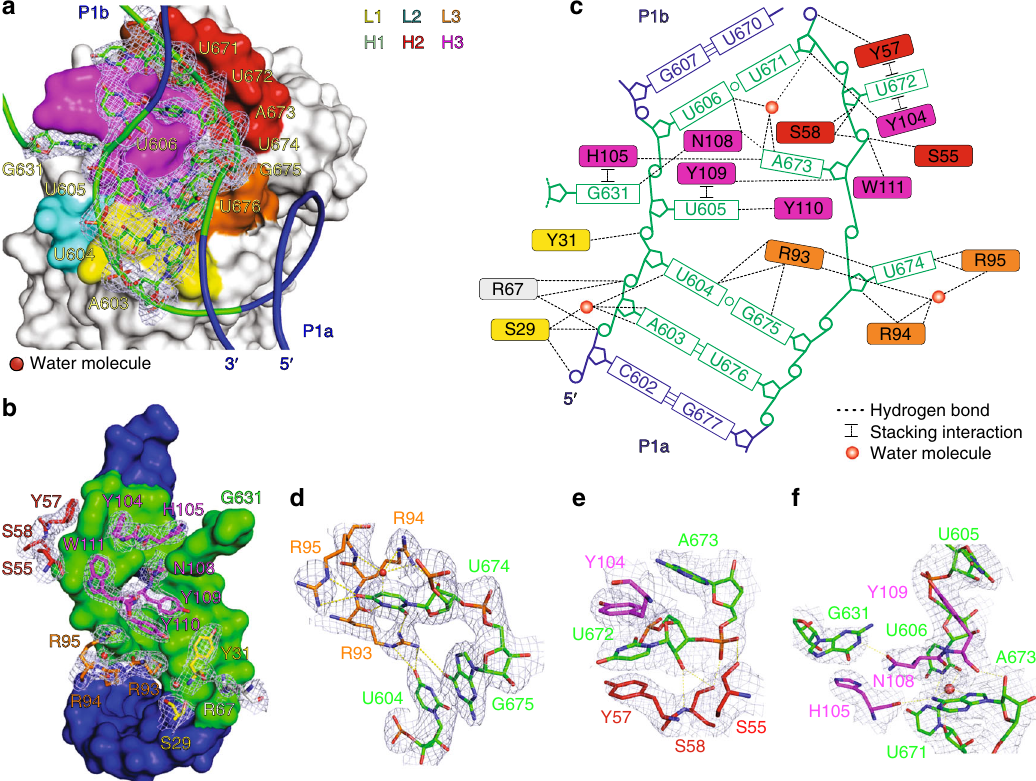
Fig. 3 Structural features of the dV – Fab binding interface. a Molecular surface of the Fab HAVx and a cartoon of the RNA (L1 bulge) showing the Fab CDRs (L1, L2, L3, H1, H2, and H3) and interacting nucleotides of the RNA epitope including G631. b Molecular surface of the RNA interface (L1 bulge and G631) and the Fab residues that are involved in binding interactions with the RNA epitope. c Schematic summary of Fab – RNA interactions. R67 (gray) represents a scaffold residue from the light chain ’ s constant domain. d – f Interactions between the RNA epitope and the Fab CDR residues. Epitope nucleotides and Fab CDR residues are colored analogously in all fi gures. Orange spheres represent water molecules that mediate hydrogen bonds (dashed lines in c – f re fl ect heteroatoms within hydrogen bonding distance (2.5 – 3.5 Å). Blue mesh in a , b and d – f represents the 2| F o | − | F c | electron density map at 1 σ contour level and carve radius 1.8 (Fig. 2d, Supplementary Fig. 8 and Supplementary Table 1). In